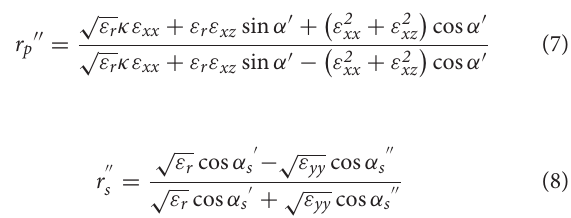
FIGURE 5 | The schematic diagrams of the proposed THz optical isolator when α component: the forward wave experiences negligible reflectance and the backward wave experiences high reflectance at 2.136 THz (A) ; or the forward wave experiences high reflectance and the backward wave experiences negligible reflectance at 2.178 THz (B)